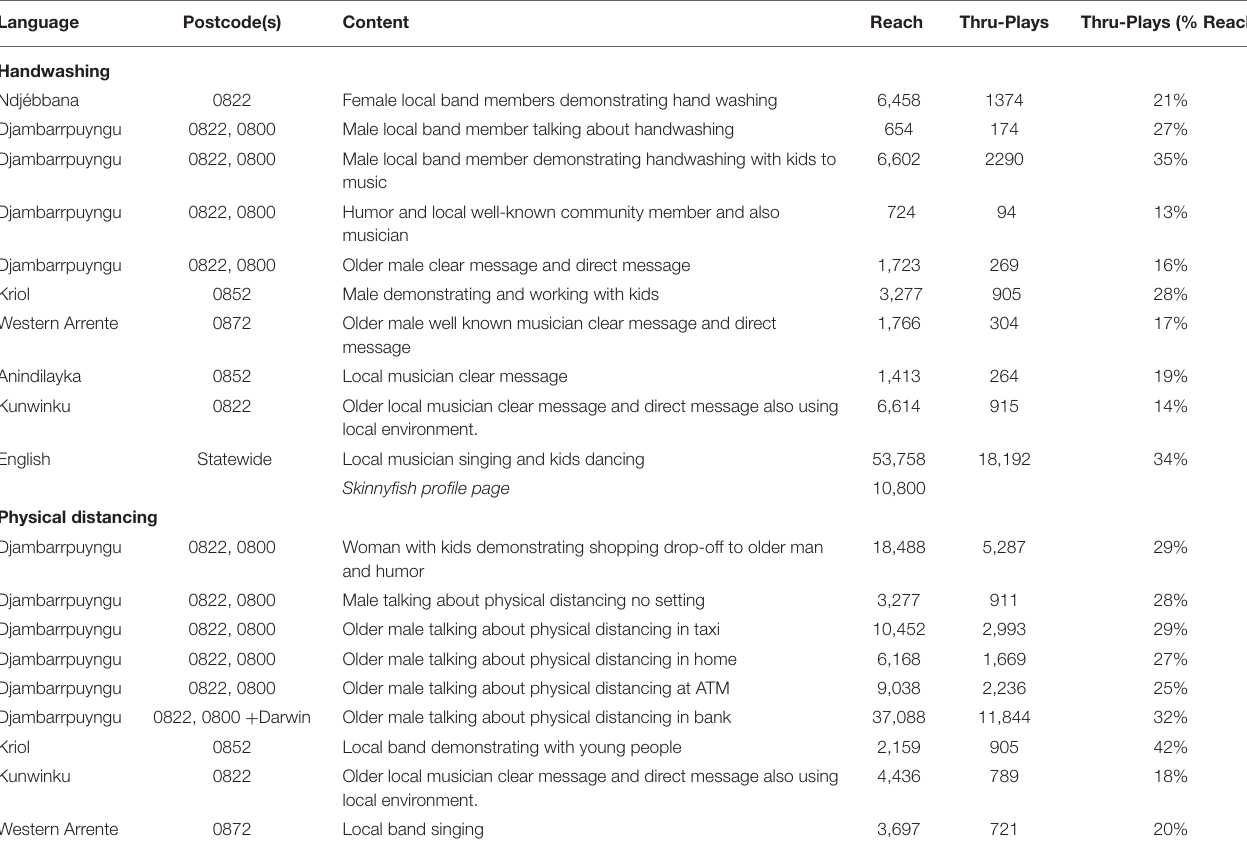
TABLE 3 | Individual ad content, language, postcode, reach and ThruPlays.